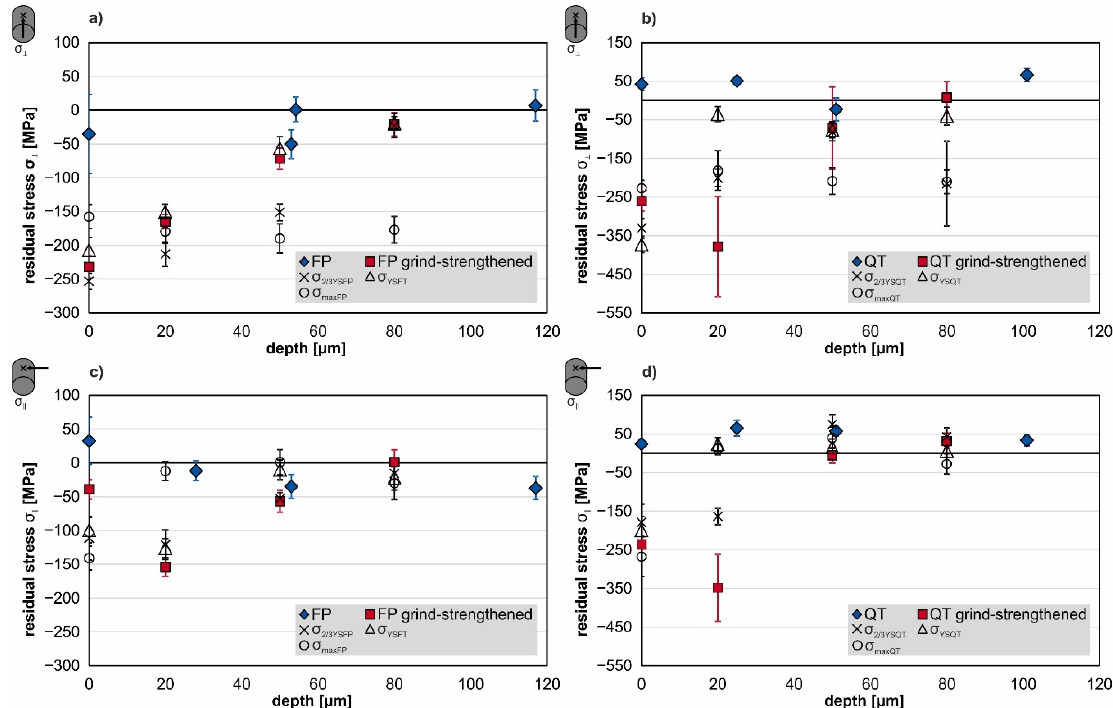
Figure 7. Residual stress depth profiles transverse (upper images) and parallel (lower images) to grinding direction of grind-strengthened specimens in FP-condition ( a , c ) and QT-condition ( b , d ).